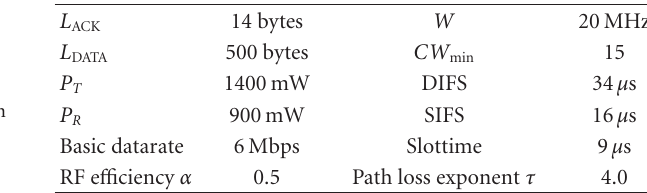
Table 1: Simulation